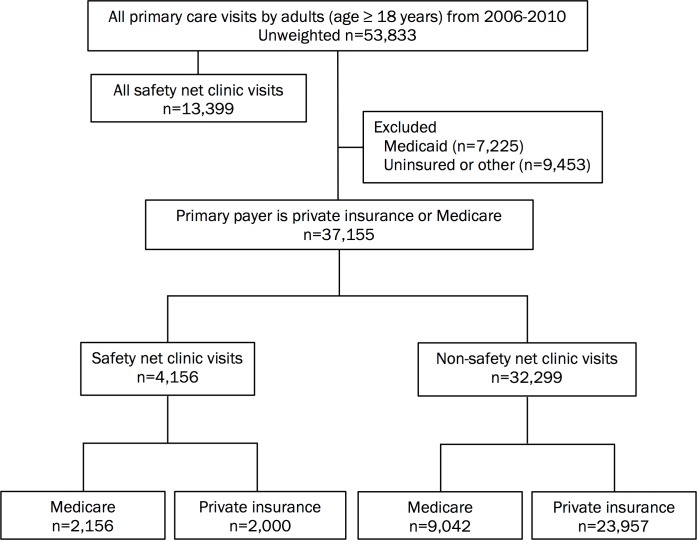
Study Flowchart.